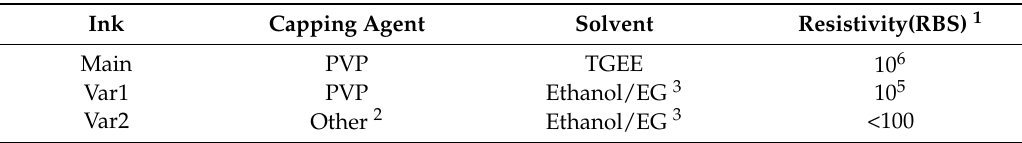
Table 1. Comparison using different inks show that the PVP capping agent has a large influence on the resistivity increase.